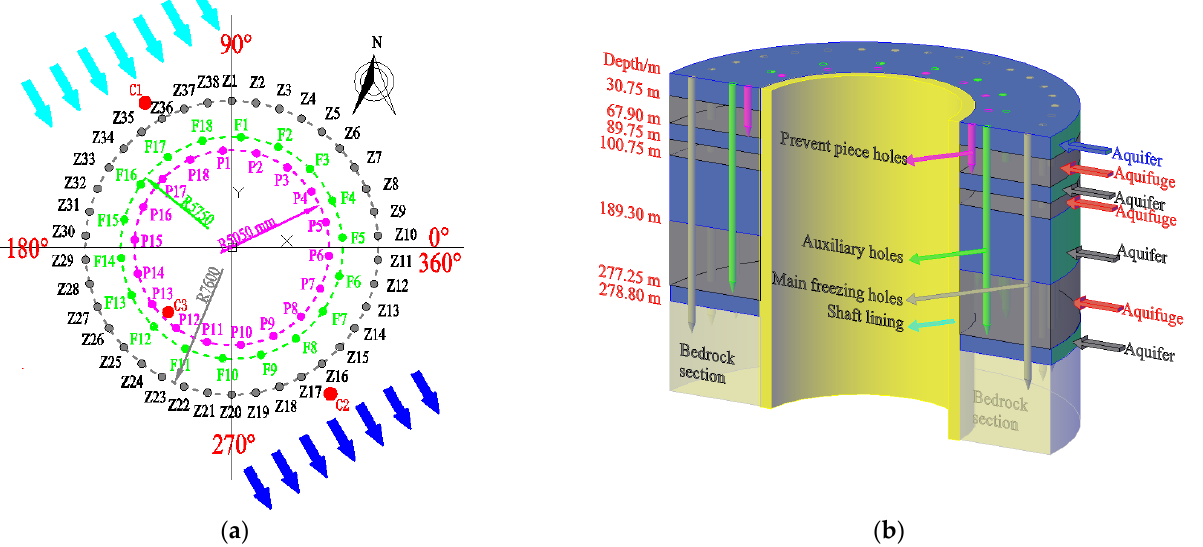
Figure 1. Freezing holes design layout. ( a ) Plane layout of freezing holes; ( b ) three-dimensional diagram of freezing holes. diagram of freezing